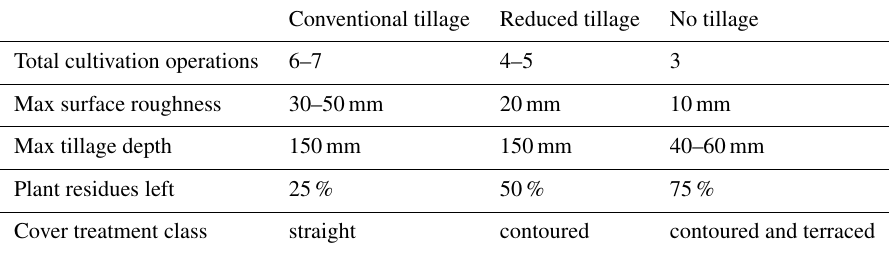
Table 2. Tillage management scenarios for maize and wheat cultivation.